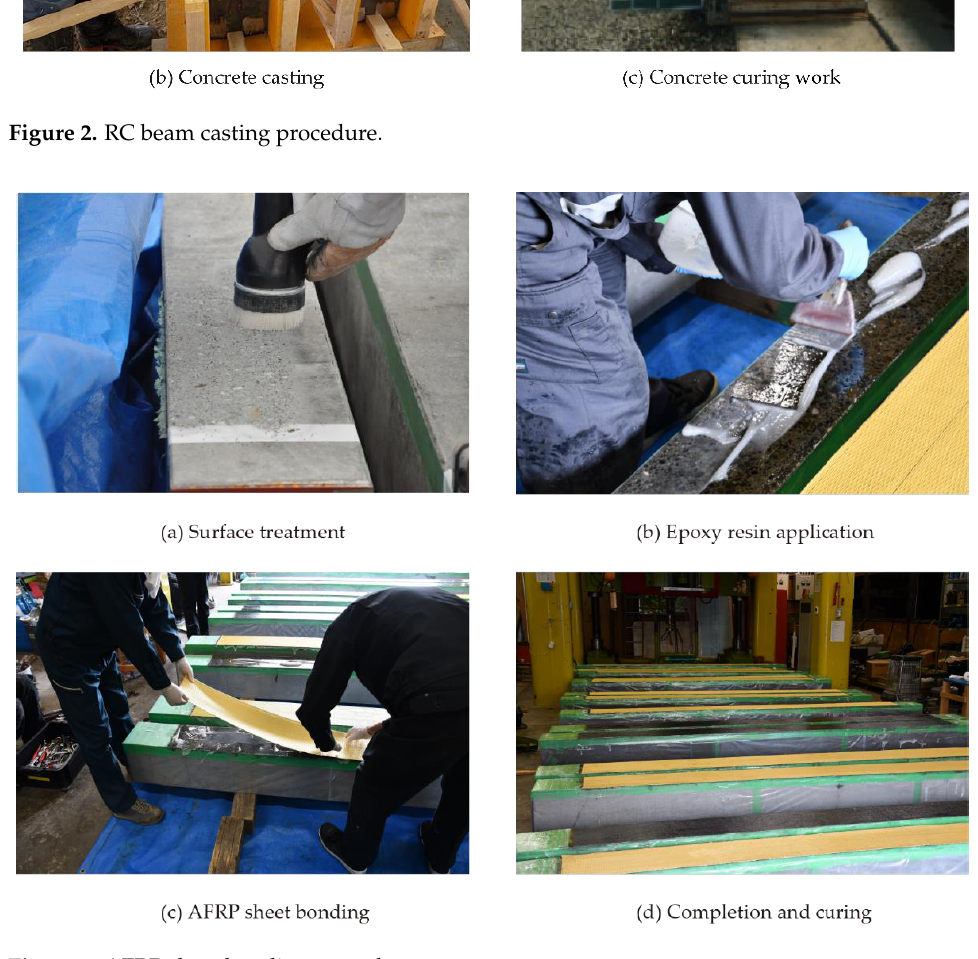
Figure 3. AFRP sheet bonding procedure.